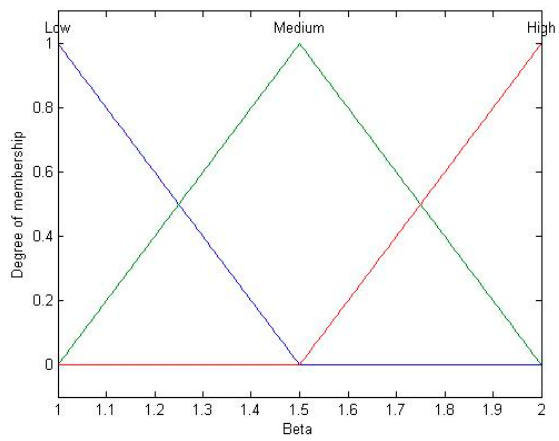
Figure 13. Output called β .